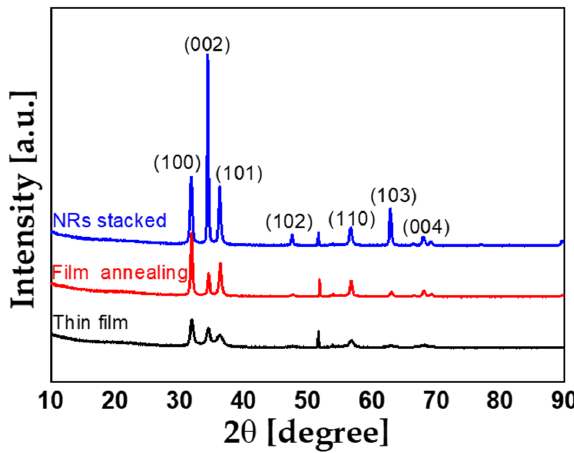
Figure 3. XRD data of ZnO (40 nm) thin film, film pre-annealing, NRs growth type devices; The (002) peak was remarkably increased in the NRs stacked type device grown by supplying a source of ZnO nanorods through hydrothermal synthesis.